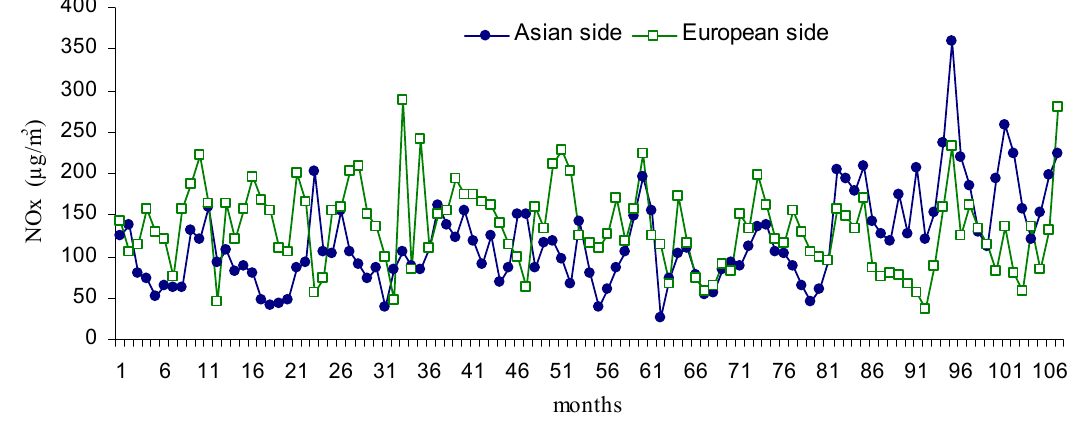
(µg/m 3 ) during the study period (Jan 2002–Dec x